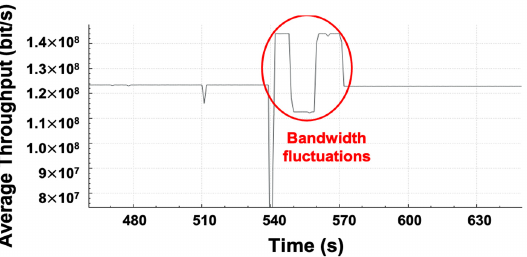
Figure 7. Real-time fluctuations on the average throughput due to a fall in the transmission